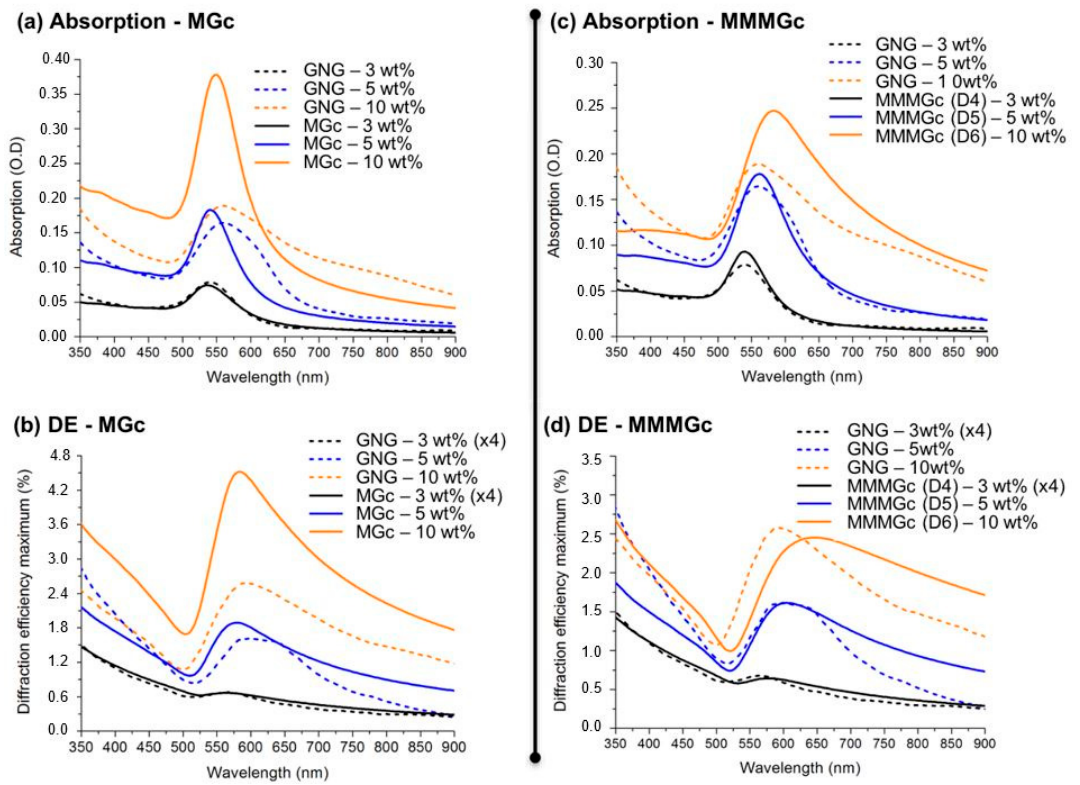
Figure 7. Comparison between the absorption spectra and the diffraction efficiency (DE) spectra measured experimentally and simulated using the MGc model ( a , b ) and the MMMGc model ( c , d ).